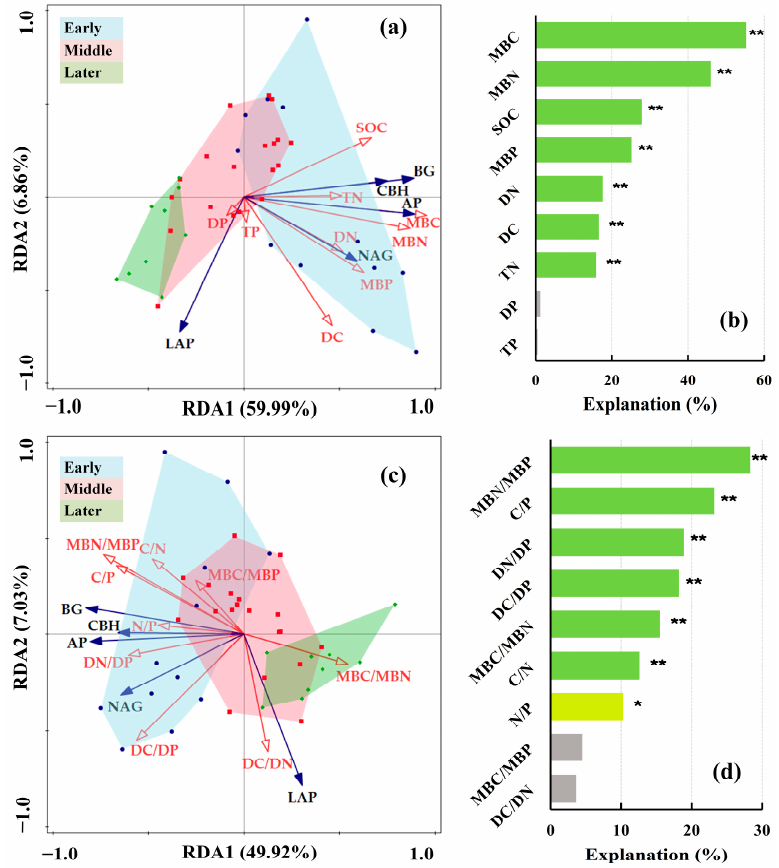
Figure 6. Redundancy analysis (RDA) identifies the relationships between extracellular enzyme activities (EEAs) and ( a , b ) microbial biomass, total nutrients, dissolved nutrients, and ( c , d ) their stoichiometry. * p < 0.05, ** p < 0.01. Table 1. Pearson correlation coefficients between soil C, N and P fractions variables and enzyme activities.